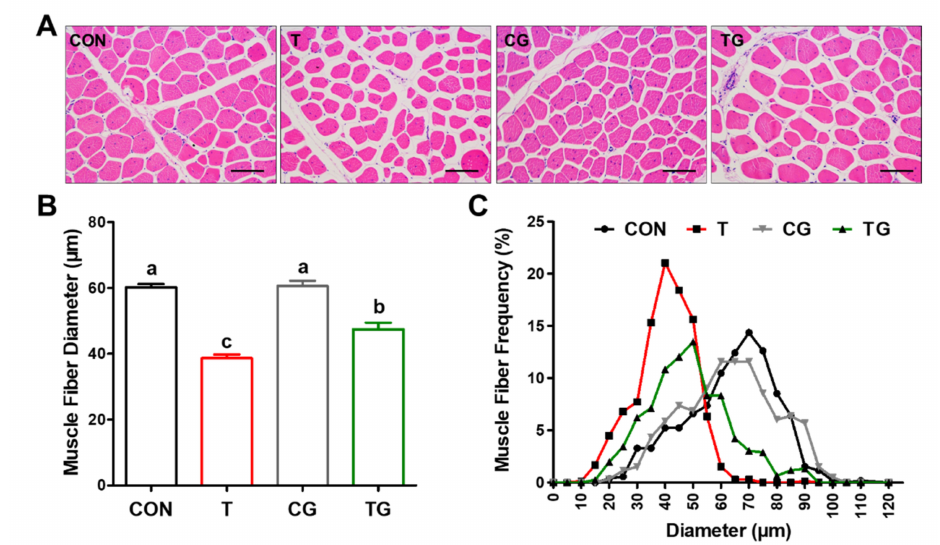
Figure 2. Effects of heat shock protein 70 expression on morphology of pectoralis major muscle fibers of broiler chickens subjected to pre-slaughter transport. ( A ) Representative images of hematoxylin and eosin staining of muscle fibers. ( B ) Diameter of muscle fibers. ( C ) Muscle-fiber distribution. CON, broilers that received intraperitoneal injection of saline and were held under a normal rearing condition; T, broilers that received intraperitoneal injection of saline and were subjected to pre- slaughter transport treatment; CG, broilers that received intraperitoneal injection of glutamine and were held under a normal rearing condition; TG, broilers that received intraperitoneal injection of glutamine and were subjected to pre-slaughter transport treatment. All measurements are expressed as means ± SE ( n = 6) with different superscript letters (a–c) indicating significance ( p < 0.05).